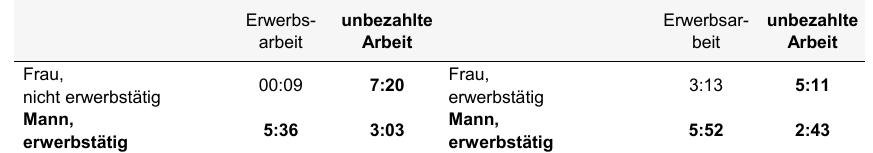
in Paarhaushalten mit Kindern, nach Familienmodell, in Stunden